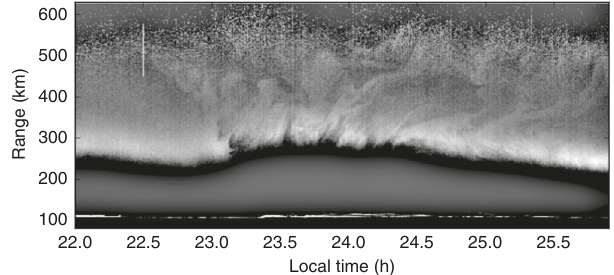
Fig. 2 Enhanced version of the topside ionospheric irregularities from the latter portion of the event. A low-pass fi lter (Gaussian with a standard deviation of 100 pixels) was applied to the original image, and the difference between the fi ltered and un fi ltered images was then plotted. Despite having units of per cubic meter, the quantity being plotted is not strictly electron density, and the grayscale is